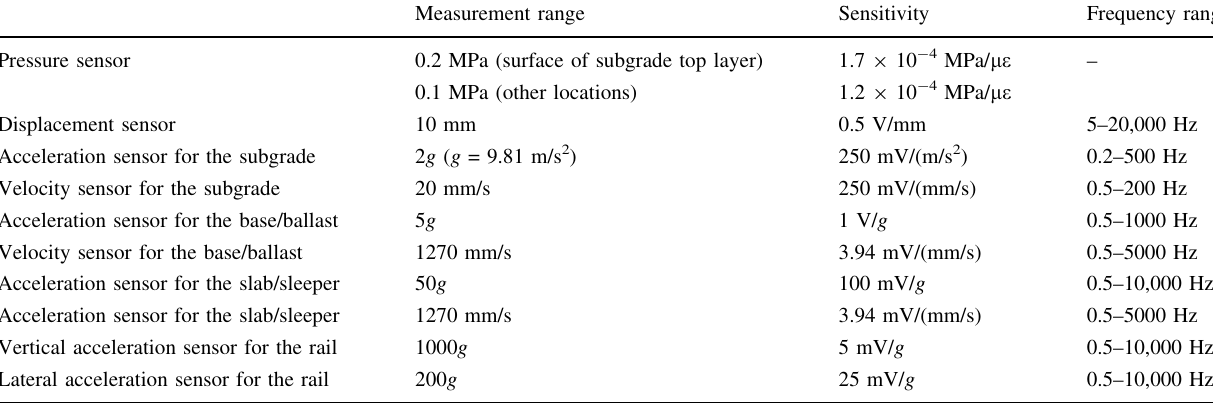
Table 4 Basic technical parameters of sensors laid in the test